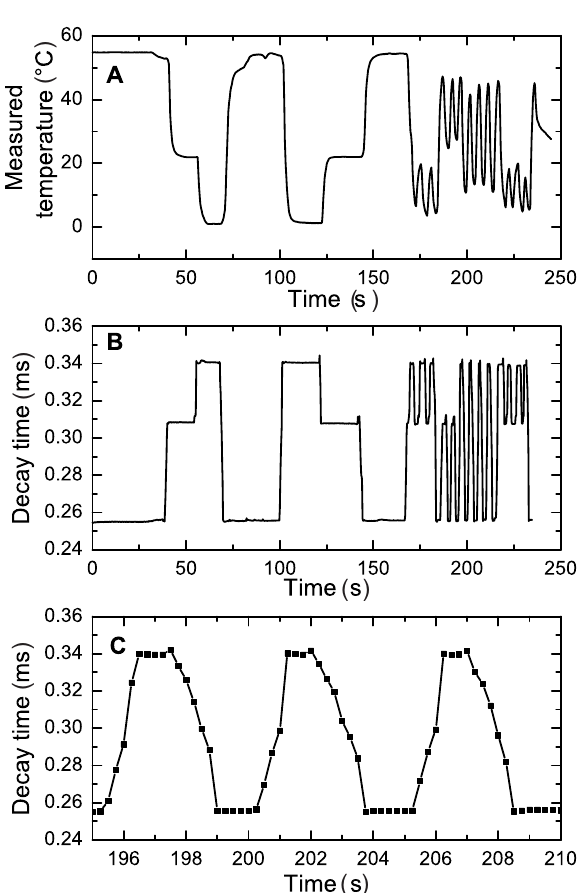
Figure 11. Dynamic response of the temperature resistance thermometer PT-100 ( A ) and fiber optic microsensor ( B , C ) to temperature changes between the beakers with water kept at 55 ◦ C, 22 ◦ C and ∼ 1.3 ◦ C (ice water). C is the zoom-in for the interval 195–210 s corresponding to the curve